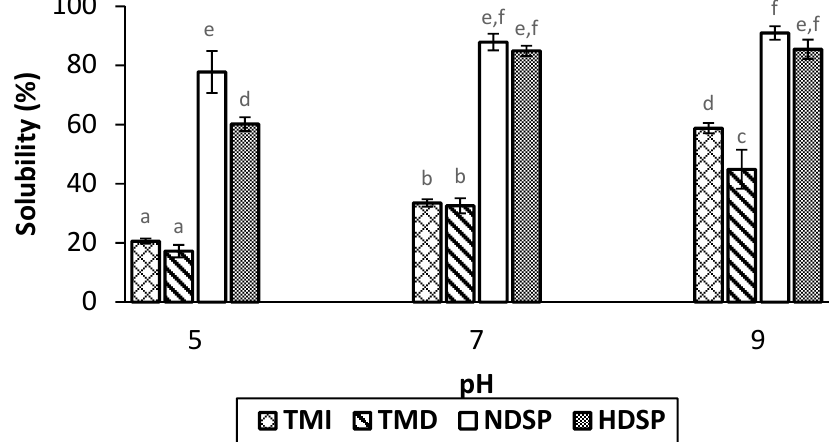
Figure 3. Protein solubility at pH 5, 7 and 9 of TMI, TMD, NDSP, and HDSP fractions. Different letters indicate significant differences ( p < 0.05).